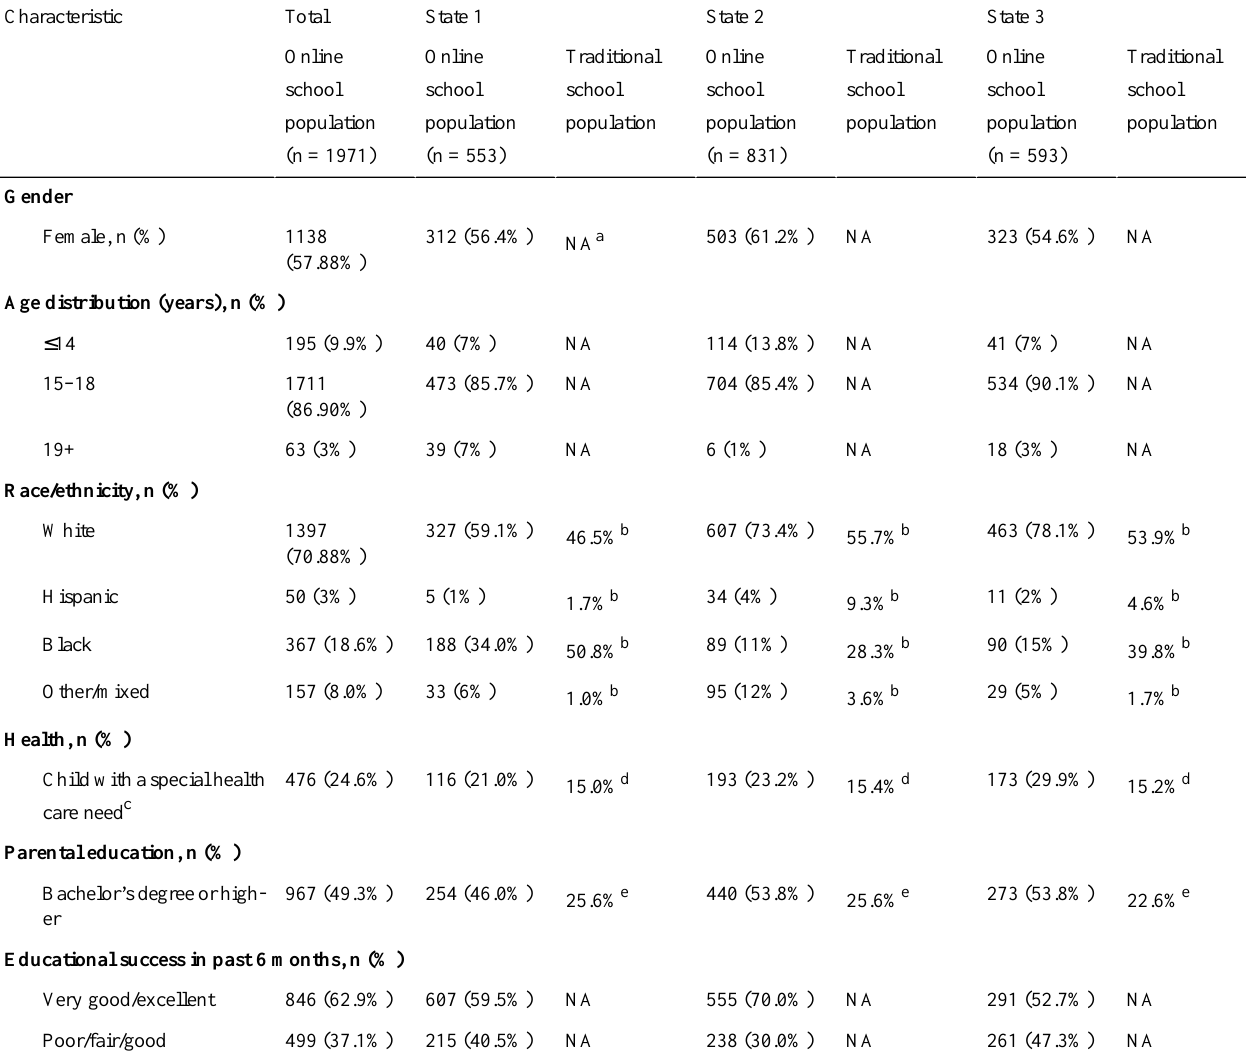
Table 1. Demographics of students in online school and traditional school according to parental